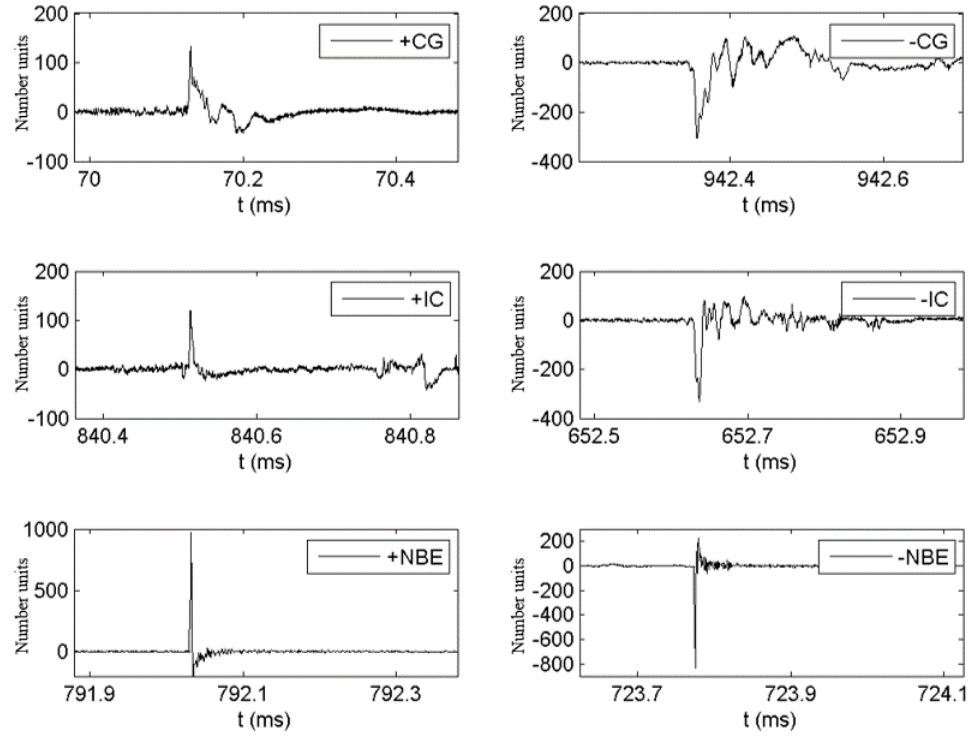
Figure 7. Typical waveforms of different discharge types corresponding to +CG, −CG, +IC, −IC, +NBE, −NBE.